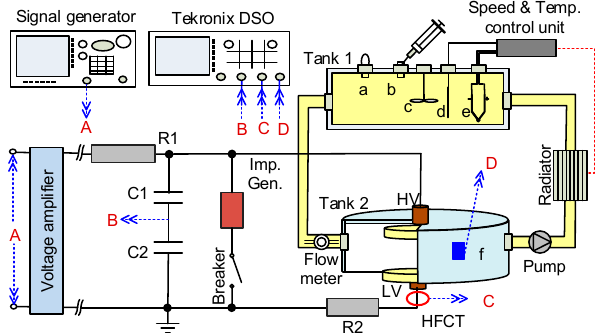
Figure 1. Schematic diagram for PD test, where (a) pressure relief valve, (b) injection port, (c) blender, (d) thermometer, (e) heater and (f) UHF sensor. The red letters A, B, C, and D stand for different kind of signals.